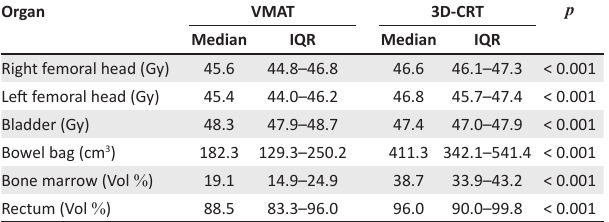
TABLE 2: Volumetric modulated arc therapy versus three-dimensional conformal radiation organ at risk dosimetry.